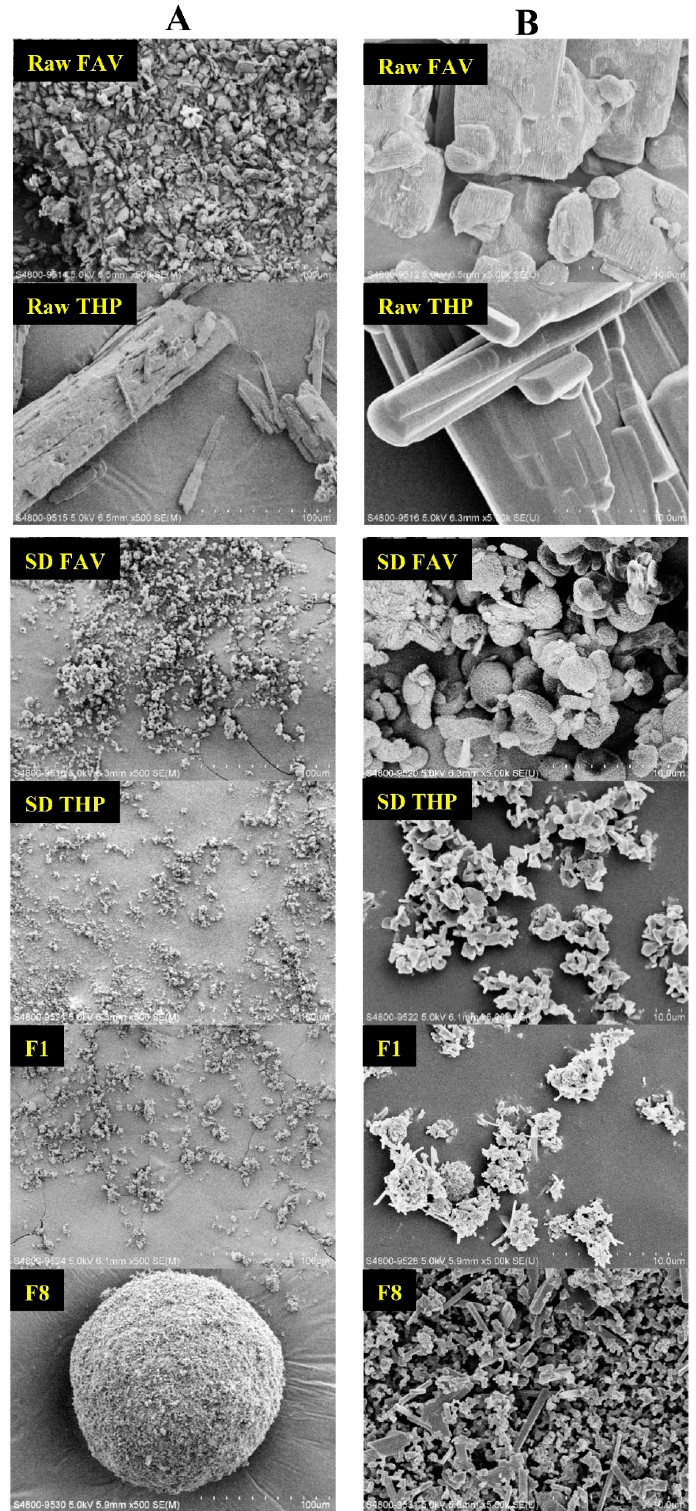
Figure 9. Scanning electron micrographs of raw cocrystal formers, spray-dried cocrystal formers, and spray-dried FAV-THP cocrystal powders (F1 vs. F8 formulations) at 500× magnification (Panel A ) and 5000× magnification (Panel B ).